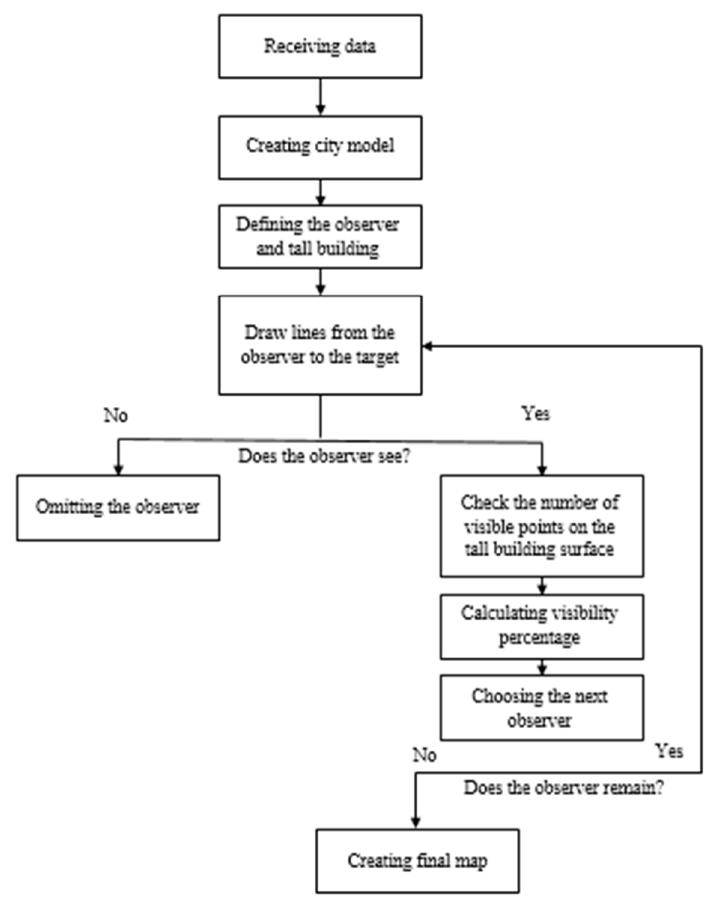
Figure 20. The fuzzy visibility’s programmed process used in the Matlab software.